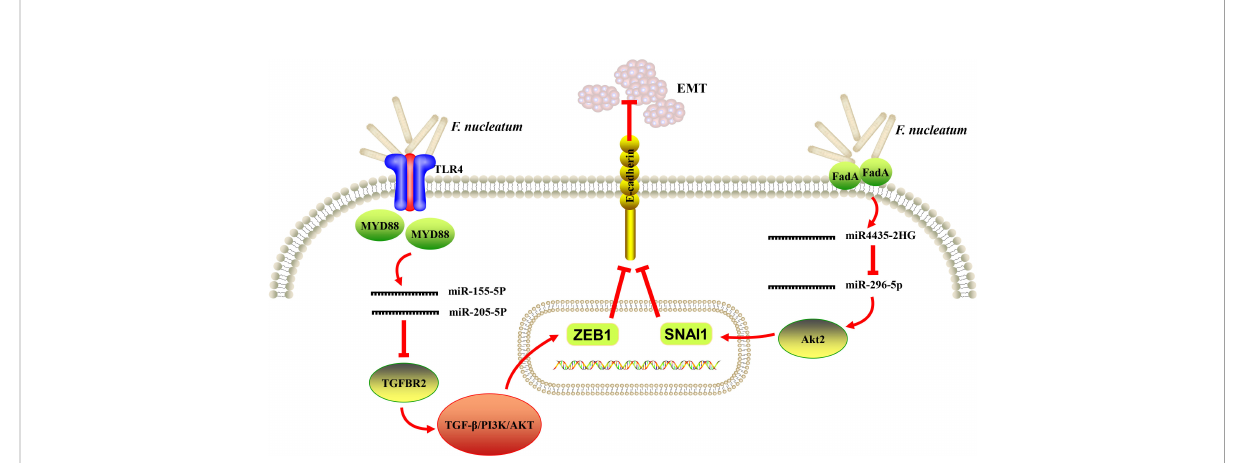
FIGURE 2 A schematic diagram of the proposed epithelial-to-mesenchymal transition (EMT) mechanism of Fusobacterium nucleatum (F. nucleatum) in oral and head and neck cancer based on the literature reviews (64, 78,